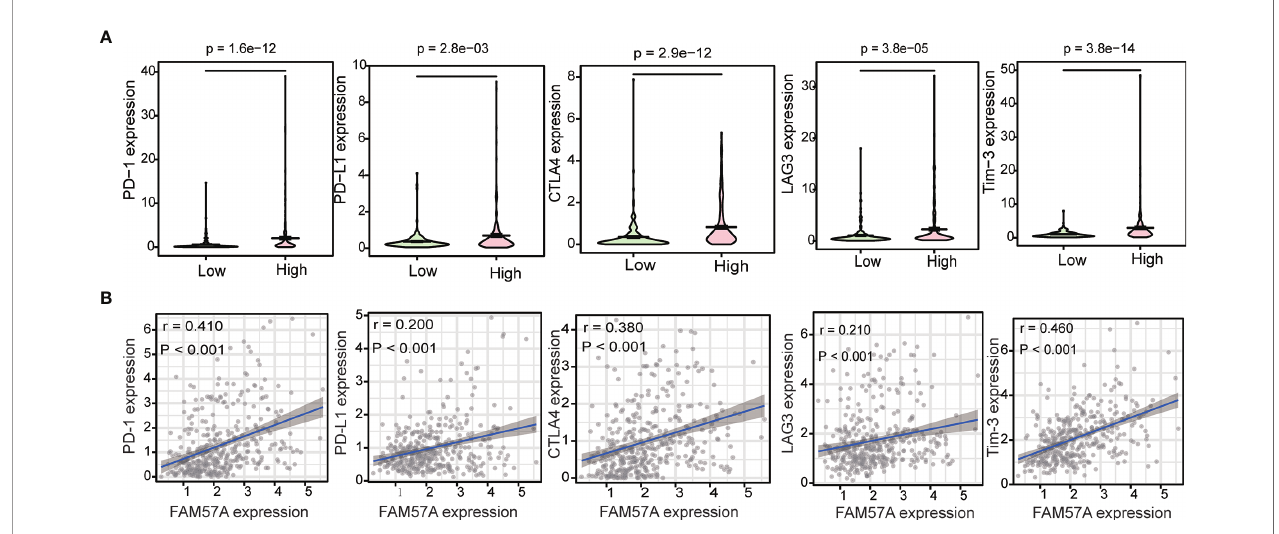
FIGURE 12 | Correlation between FAM57A expression and immune checkpoint genes (PD-1, PD-L1, CTLA-4, LAG3, and Tim-3). (A) Differential analysis of immune checkpoint genes with high and low expression levels of FAM57A. (B) Correlation analysis between FAM57A expression and immune checkpoint